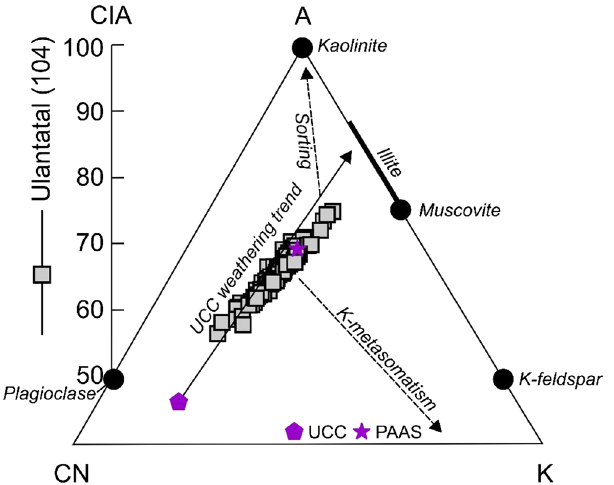
Figure 5. An A–CN–K (Al 2 O 3 –CaO* + Na 2 O–K 2 O) diagram 74 in which the variably weathered Ulantatal sequence sediments are plotted (grey square symbol). They follow the Upper Continental Crust (UCC, purple polygon symbol) weathering trend close to the composition of Post-Archean average Australian Shale (PAAS, purple star symbol). The range and average value of the chemical index of alteration (CIA) and the